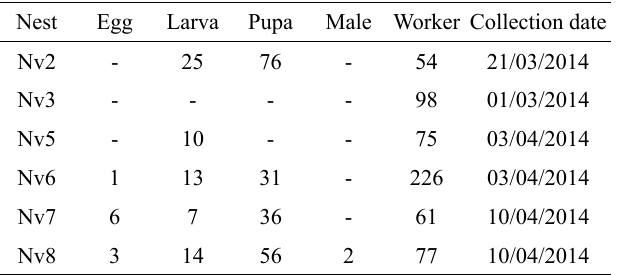
Table 1 . Populations of Neoponera verenae in six